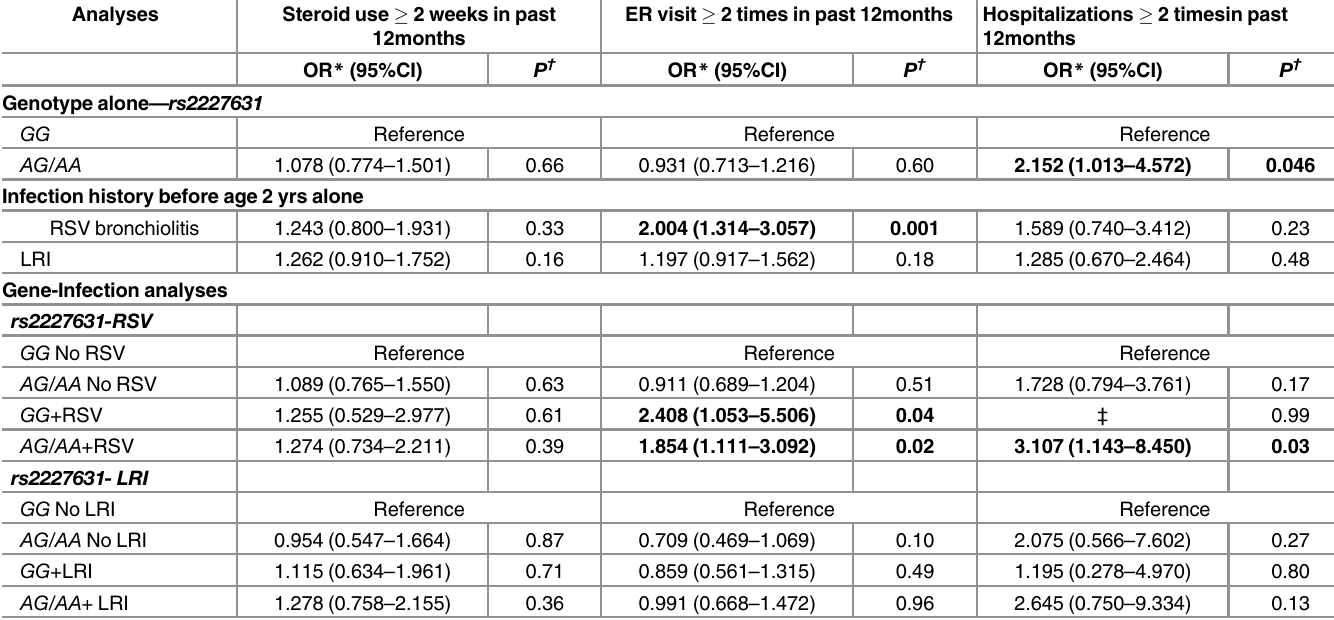
Table 3. Adjusted effect of rs2227631 , infection and rs2227631 gene-infection interaction on asthma exacerbations. Analyses Steroid use (cid:1) 2 weeks in past